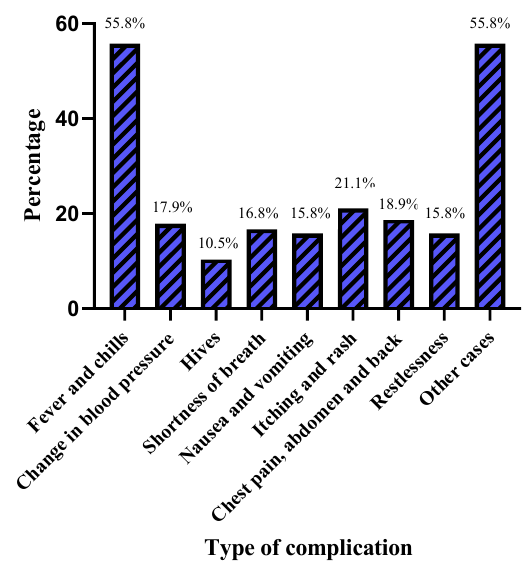
Figure 2. Frequency of Complications After Transfusion in Imam Khomeini Hospital.